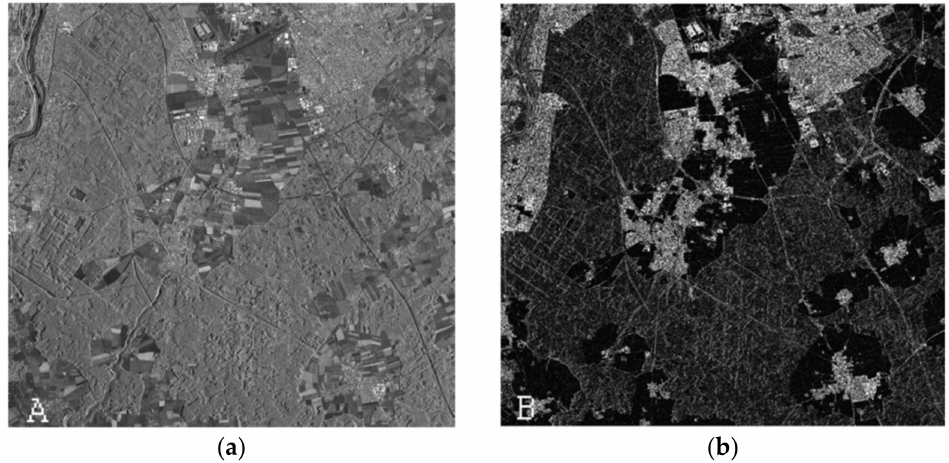
Figure 20. Filtered TerraSAR-X intensity layer ( a ) and calculated speckle divergence layer ( b ) of a subset of the region of Munich. The built-up areas are characterised by high values of speckle divergence. Source: